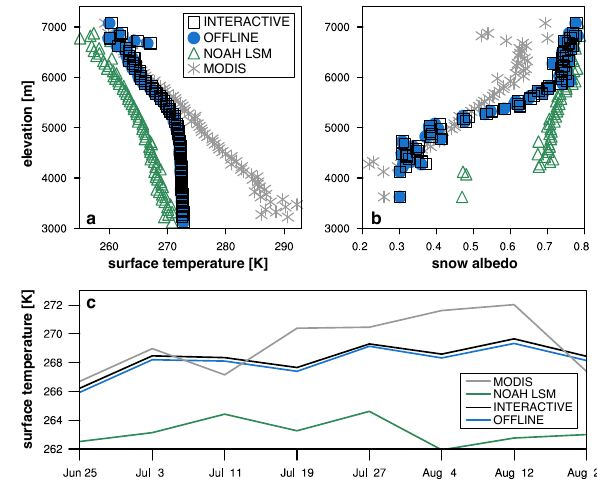
Fig. 2. Comparison between WRF-CMB D3, Noah LSM, and MODIS for land surface temperature, (a) averaged from 25 June– 28 August 2004, and in 50m elevation bins; (c) the mean time series above 5200m elevation; and for (b) snow albedo, averaged between 25 June–31 August 2004, over glacier grid cells where at least 25% of the daily times are